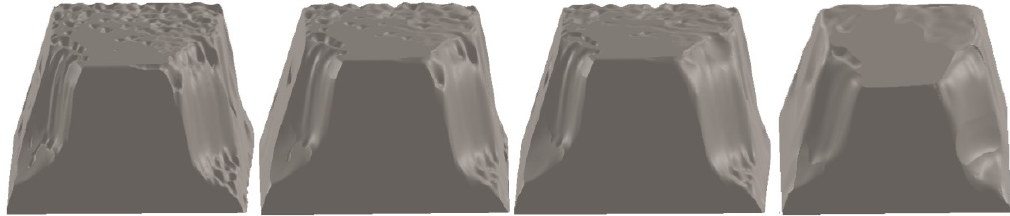
Figure 22. FSML focusing evaluation operator adopts different evaluation windows and original 3D entities of public part.